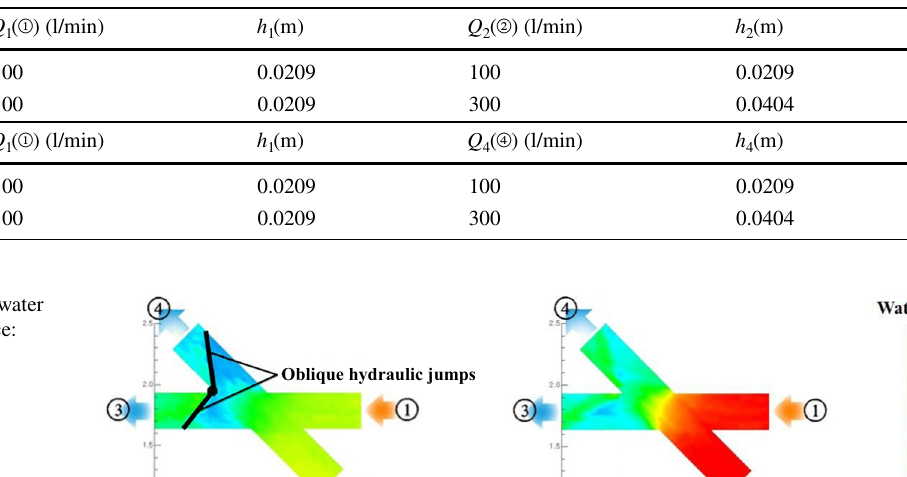
Table 1 Inflow conditions for cases I and II (①, ②, and ④: channel number)